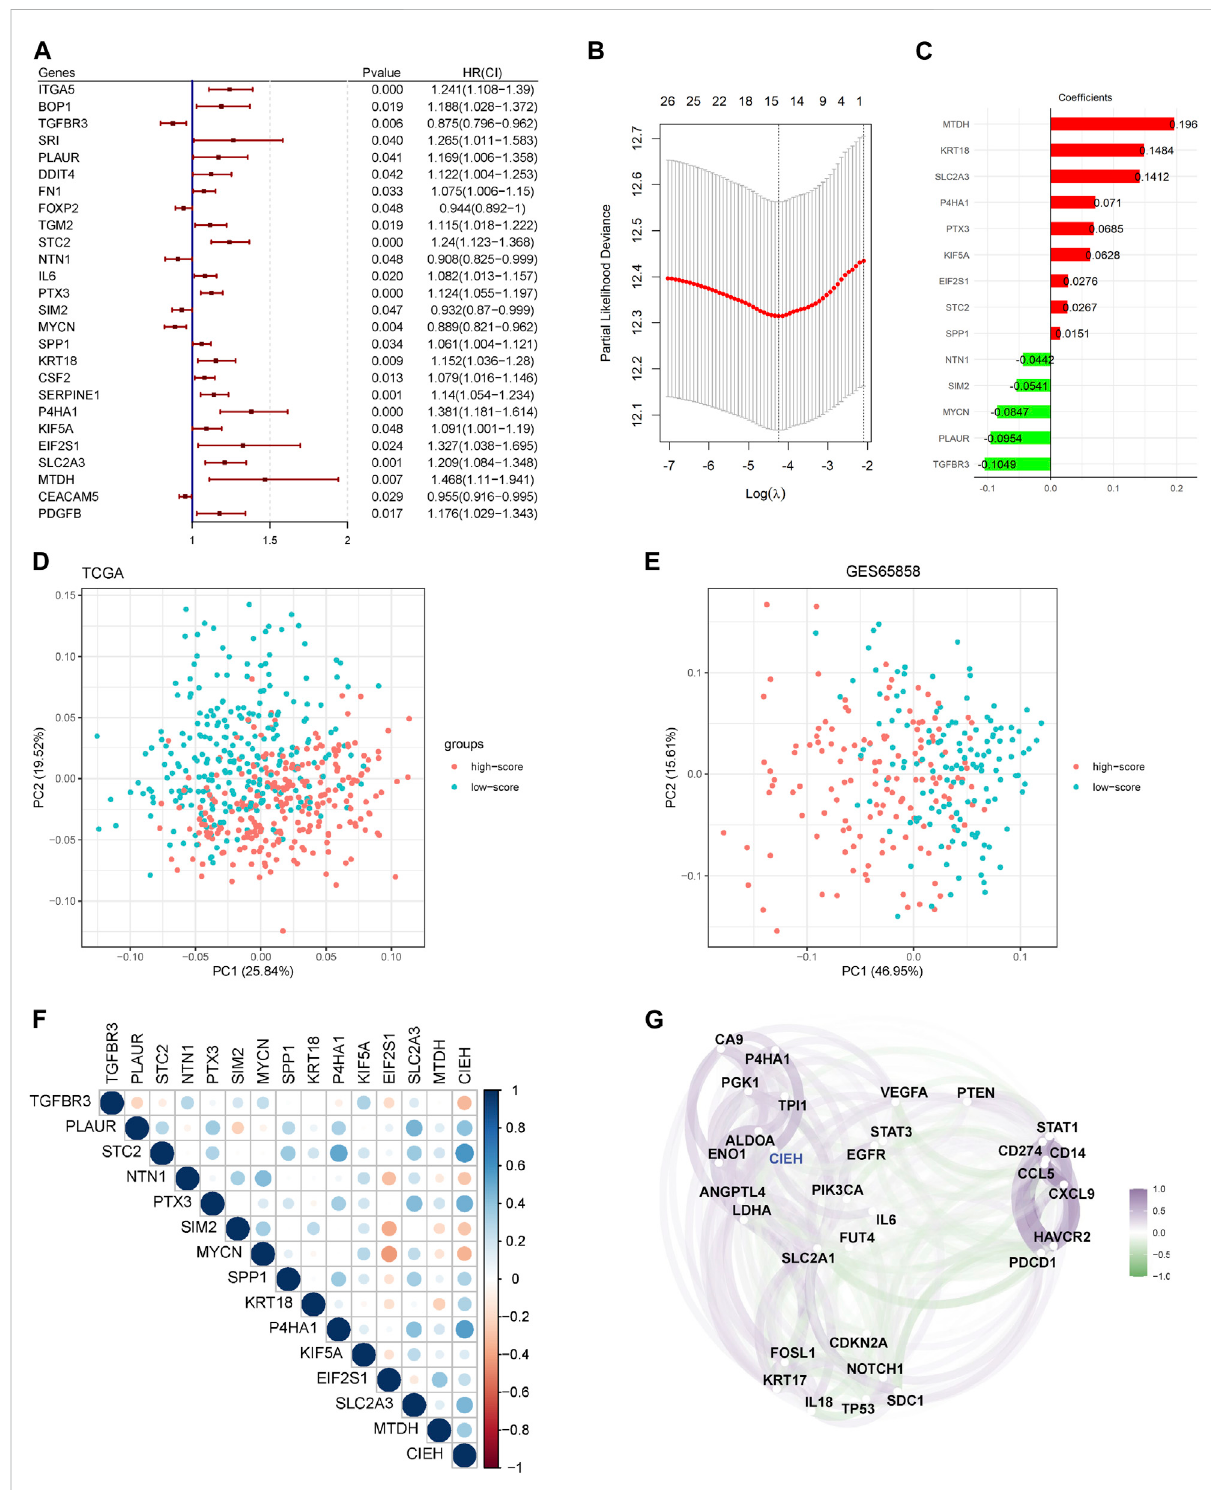
FIGURE 2 Predictive modelingand the CIEH. (A) . UnivariateCox regressionanalysisof twenty-six prognosticgenes. (B) . Optimizationparameters of lasso Cox model. (C) . Genes screened by Lasso Cox model and coef fi cient values of each gene. (D) . PCA analysis of high/low score groups in TCGA. (E) . Analyse of PCA for groups with high and low scores in GSE65858. (F) . Correlation between CIEH model and 14 prognostic factors. (G) . Correlation between CIEH and hypoxia-immune signature